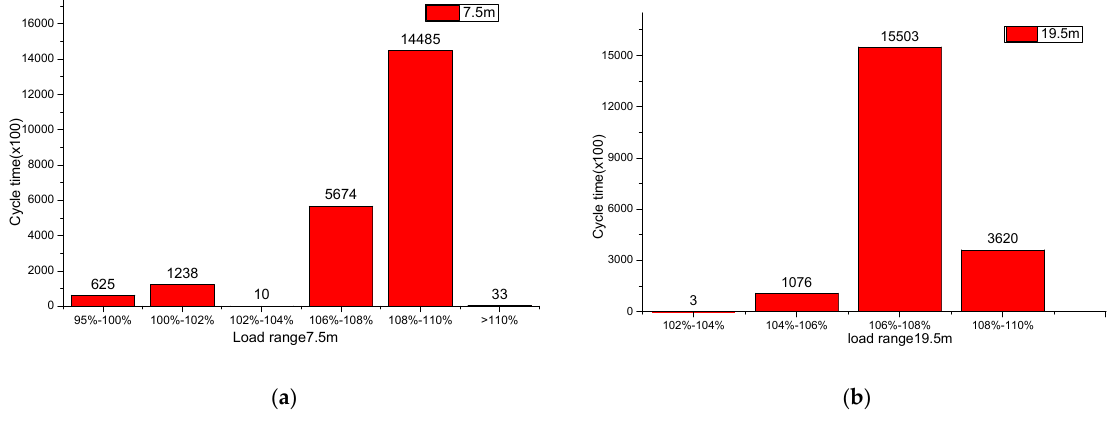
Figure 14. Two million cycle frequency distribution of the bending moment. ( a ) Frequency distribution of the bending moment in section 7.5 m; ( b ) Frequency distribution of the bending moment in section 19.5 m.